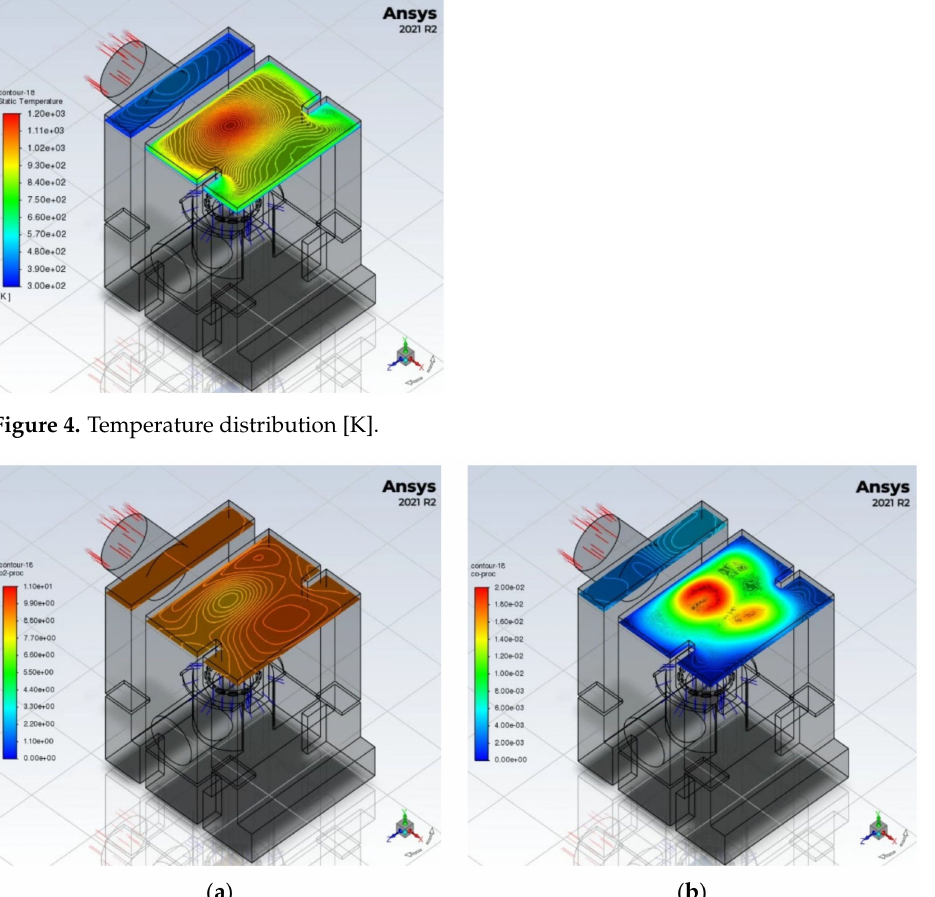
Figure 5. ( a ) O 2 concentration [%]; ( b ) CO concentration